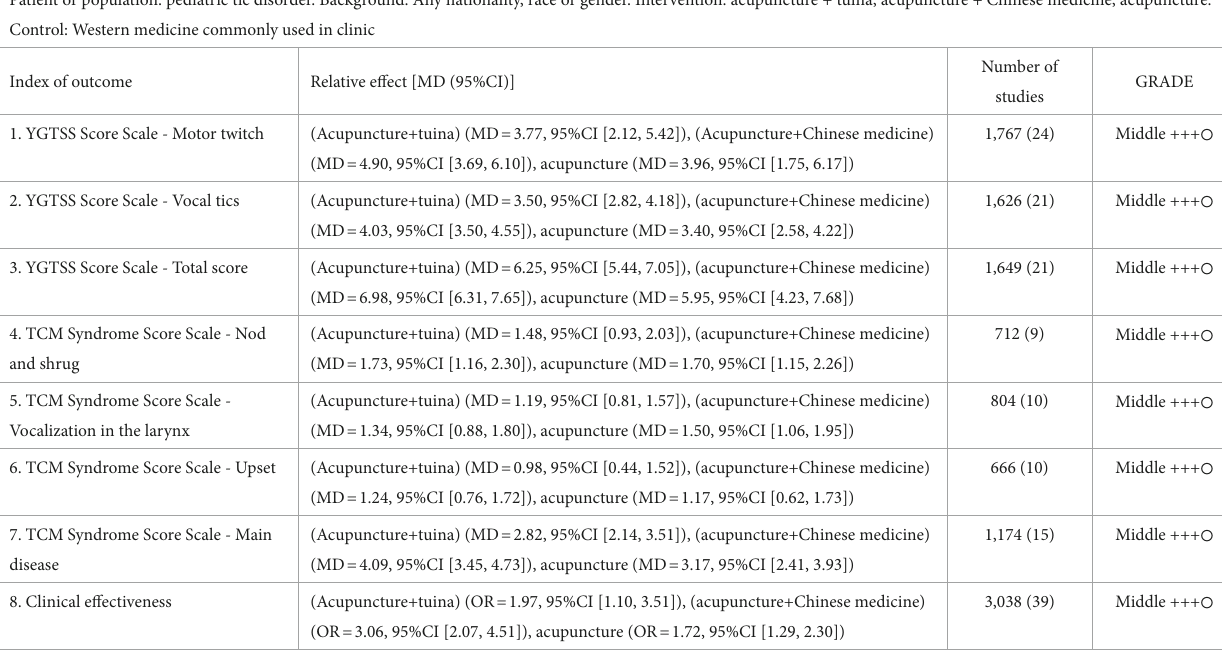
TABLE 4 Results of GRADE classification of outcome indicators. Comparison of acupuncture treatment for tic disorders in children Patient or population: pediatric tic disorder. Background: Any nationality, race or gender. Intervention: acupuncture + tuina, acupuncture + Chinese medicine,